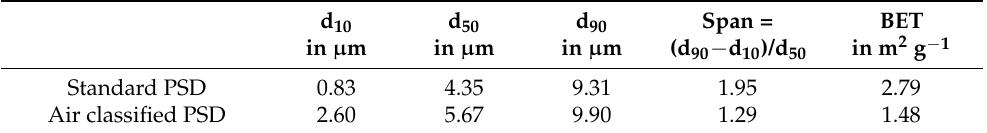
Figure 1. Particle size distributions of silicon microparticles (CLM00001) before and after air classification showing the removal of fines. Table 1. Particle properties of CLM00001 before and after air classification showing a shift to larger particle sizes and lower material surfaces.